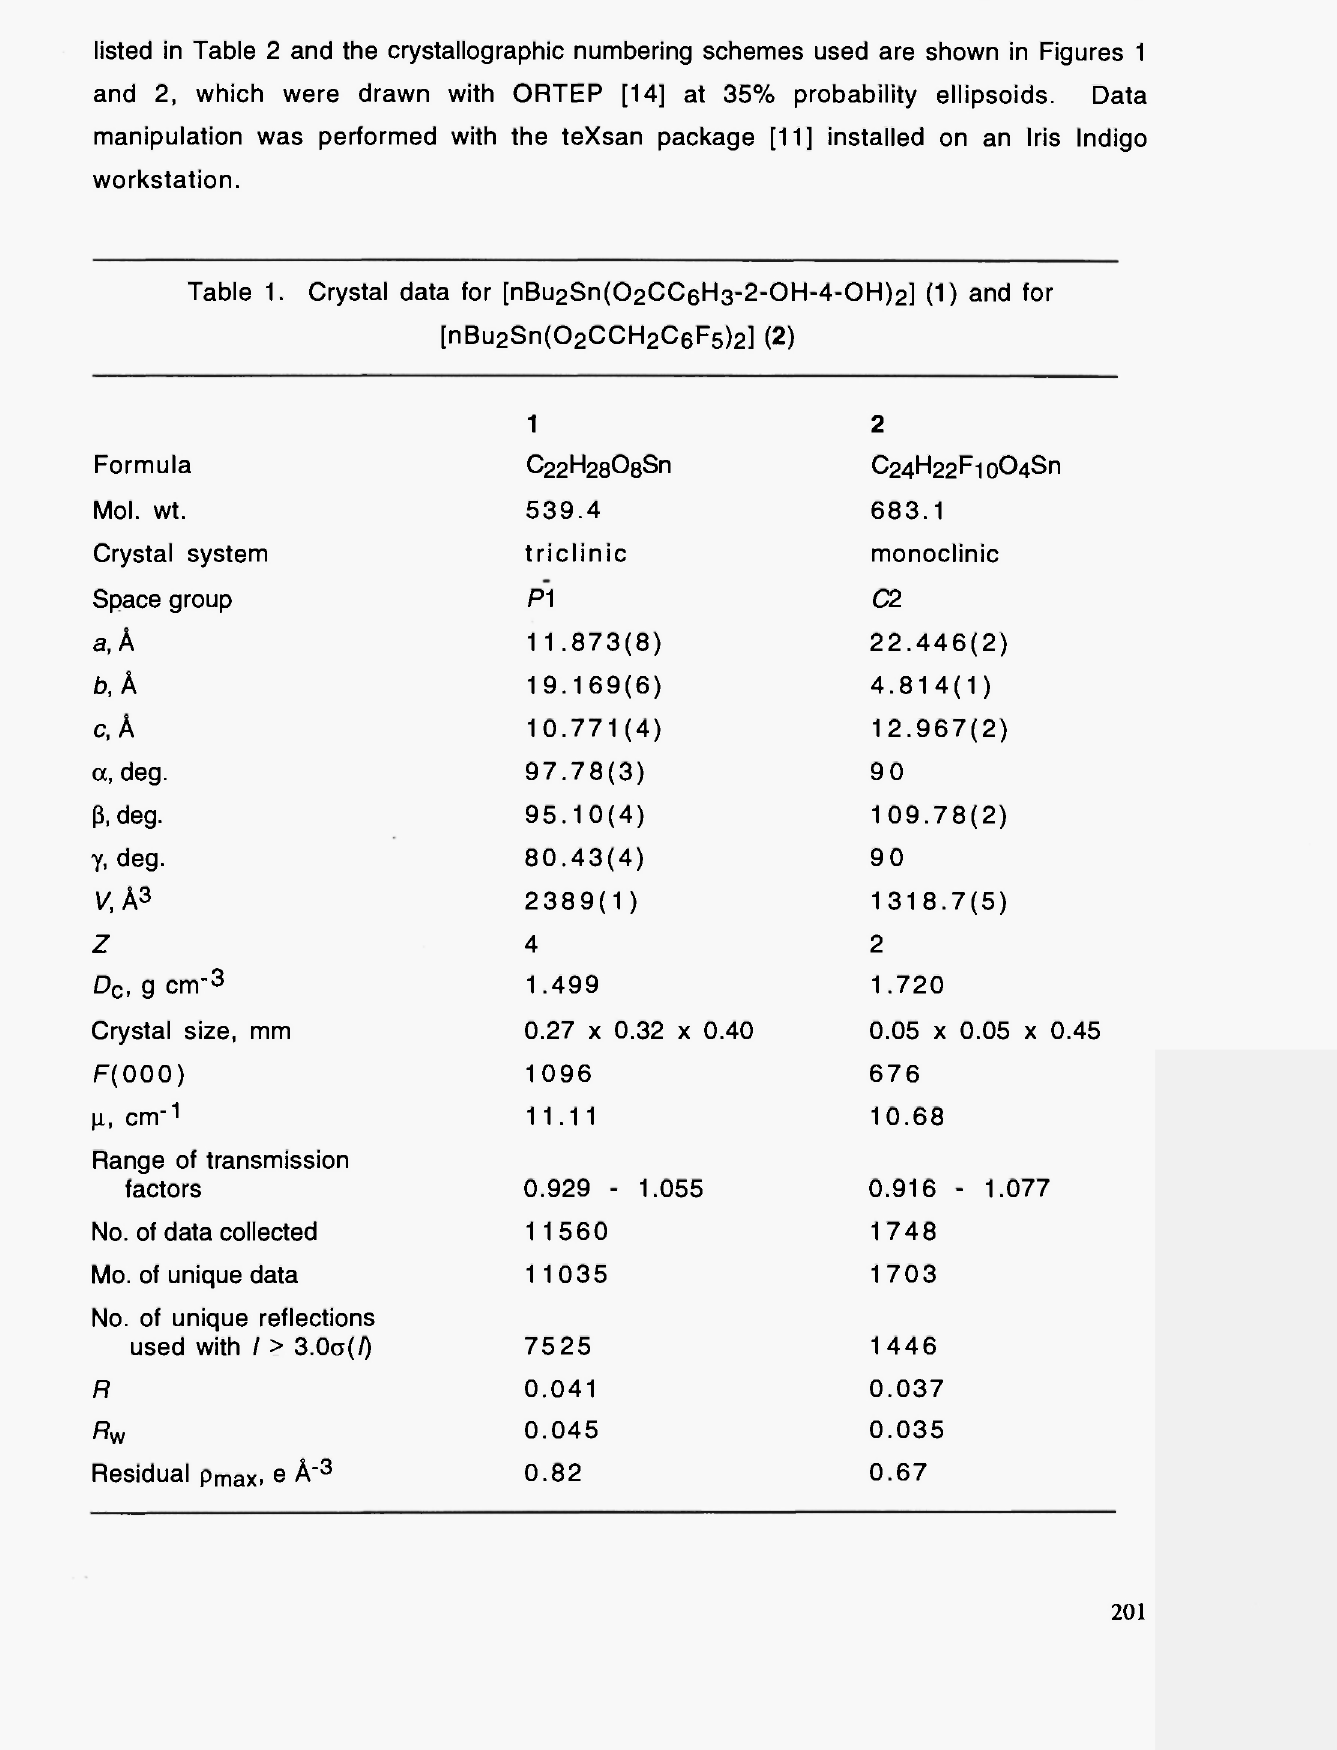
Table 1. Crystal data for [nBu2Sn(02CC6H3-2-0H-4-0H) 2 ] (1) and